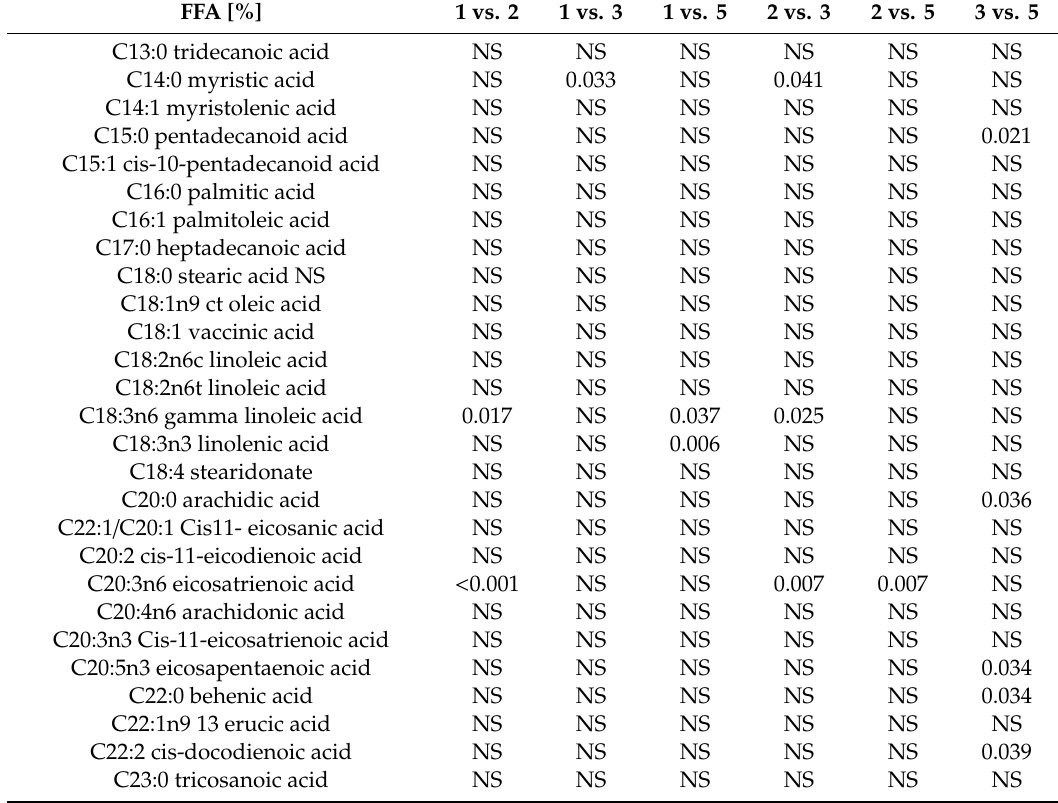
Table 7. The comparison of subgroups ( n = 74) in regard to TOAST classification and FFA. FFA [%] 1 vs. 2